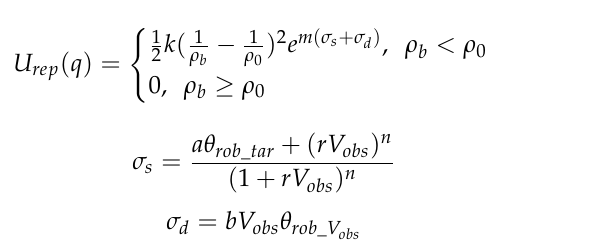
Figure 1. Obstacle avoidance velocity generation in workspace. The function of the improved repulsive field is defined in Equation